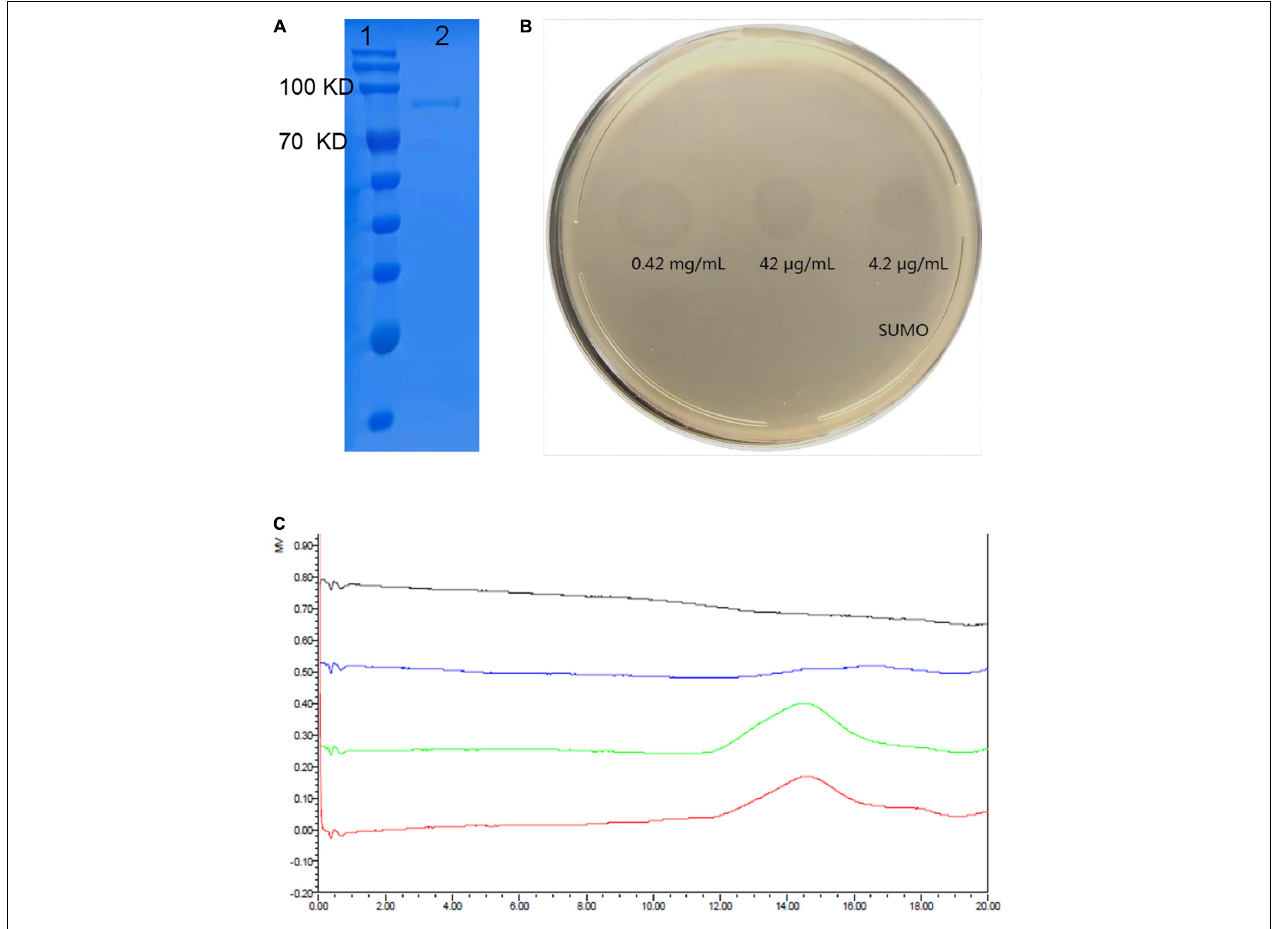
FIGURE 3 | Expression and depolymerization activity of recombinant depolymerase K19-Dpo41. (A) 10% SDS-PAGE gel analysis on the purity of K19-Dpo41. The purity of the purified K19-Dpo41 was more than 95%. Lane 1, protein marker; lane 2, purified K19-Dpo41. (B) Spot test of purified depolymerases K19-Dpo41 on K. pneumoniae strain 6570 lawn. Aliquots of serial dilutions of K19-Dpo41 was spotted onto a plate containing the K. pneumoniae strain 6570. SUMO protein was served as a negative control. (C) Size exclusion chromatography-High performance liquid chromatography (SEC-HPLC) analysis of capsular polysaccharide (CPS) treated with K19-Dpo41. Red line, purified untreated CPS; green line, CPS incubated with 10 µ g/mL SUMO at 37 ◦ C for 30 min; blue line, CPS treated with 10 µ g/mL K19-Dpo41 at 37 ◦ C for 30 min; and gray line, K19-Dpo41 incubated at 37 ◦ C for 30